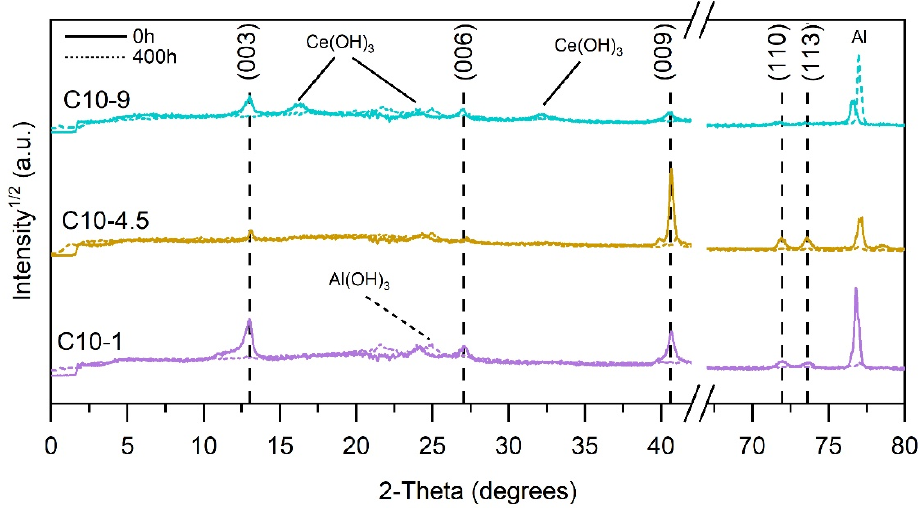
Figure 5 . XRD pattern from 10° to 110° of C10 series C10 in their fresh state (solid lines) and after Figure 5. XRD pattern from 10 ◦ to 110 ◦ of C10 series C10 in their fresh state (solid lines) and after 400 h 0.1 M of NaCl immersion (dashed lines). 400 h 0.1 M of NaCl immersion (dashed